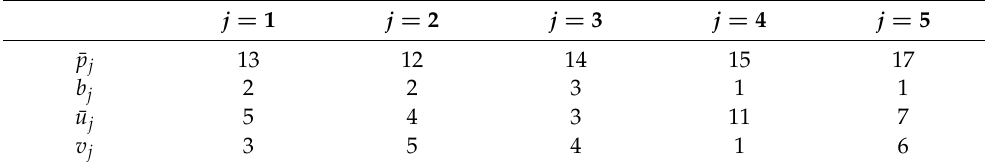
Table 1. Values of job-dependent parameters.